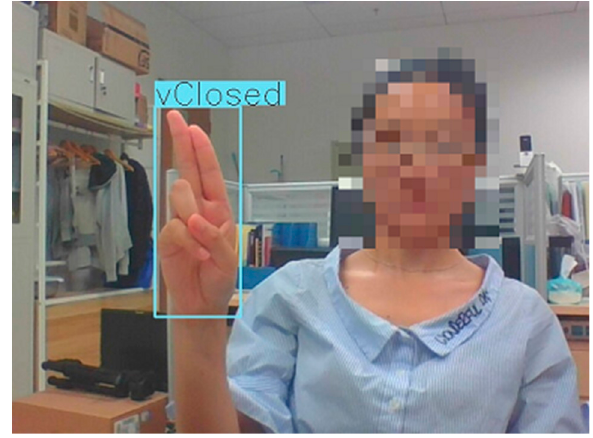
Figure 14. Result of recognition of hand postures in the corridor. Table 10. Confusion matrix for twenty-five hand postures using our dataset. Typ es